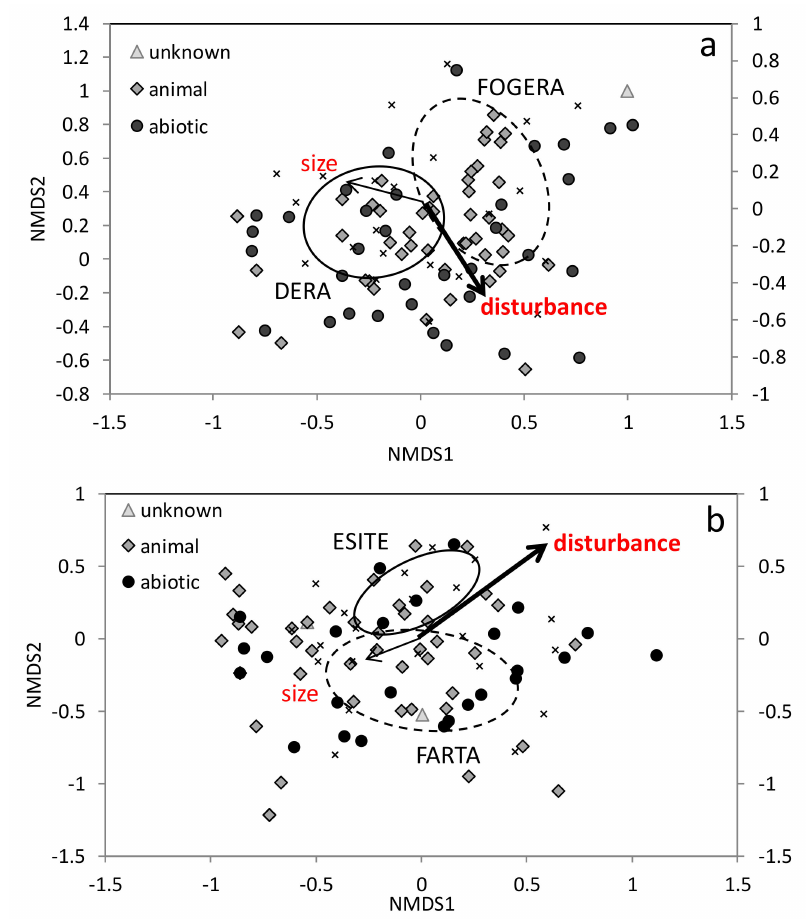
Figure 2. Non-metric multidimensional scaling ordination (NMDS) of species composition of plant species in 22 church forests in the Montane zone ( a ) and 23 church forests in the Upper Montane zone ( b ) in northern Ethiopia (the forest in the Dera Woreda in the Upper Montane zone was removed). A Bray–Curtis similarity index on abundance data was used. For a : two-dimensional stress = 0.22, Monte Carlo stress with 1000 iterations = 0.28. For b : two-dimensional stress = 0.24, Monte Carlo stress with 1000 iterations = 0.26. Ellipses denote the covariance matrix centered on the mean of each Woreda in each elevational range (Montane = Dera and Fogera; Upper Montane = Esite and Farta). Symbols represent dispersal syndromes: upward facing triangles = unknown; grey diamonds = animal dispersed species; black circles are abiotic dispersed species). Black x’s represent church forests. The lines are the variables that correlated with the ordination with bold lines denoting